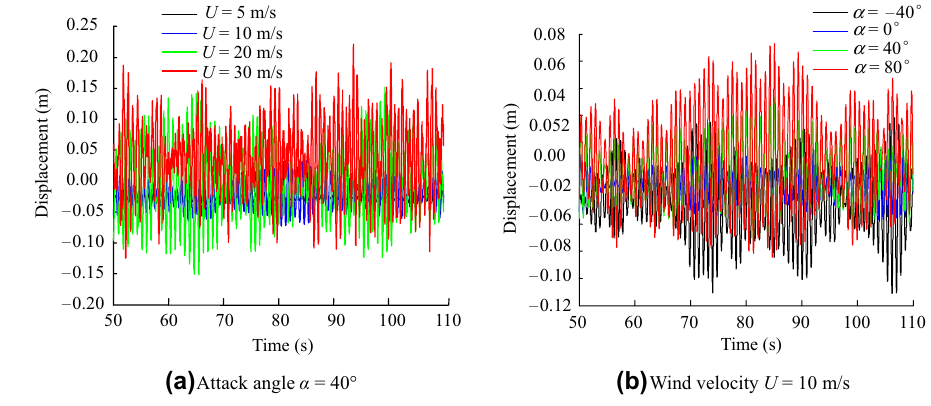
Fig. 9 Contact line vertical vibration responses under different wind velocities ( a ) and attack angles (